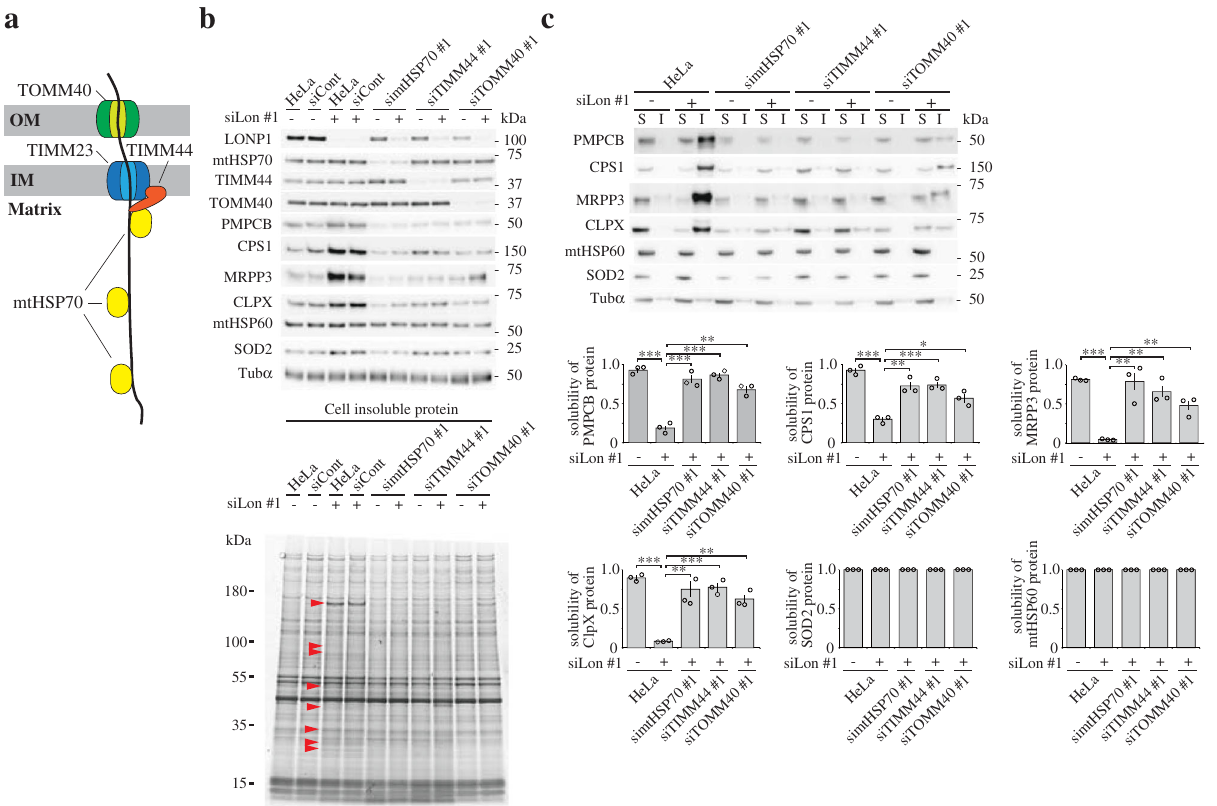
Fig. 3 Analysis of the relationship between the mitochondrial protein import machinery and protein aggregation caused by depletion of LONP1. a Model of mitochondrial protein import machinery. TOMM40 and TIMM23 are the central pore-forming subunits of the translocase complex in the mitochondrial outer membrane and inner membrane, respectively. TIMM44 is a peripheral inner membrane protein on the matrix side and mediates mtHSP70 attachment to TIMM23, and mtHSP70 binds incoming proteins to facilitate their translocation. b Analysis of insoluble proteins from HeLa cells treated with siRNAs. Cells were used for experiments 3 d after the second transfection. Upper panel , immunoblot analysis was carried out as described in the legend to Fig. 1a. Lower panel , comparison of insoluble proteins prepared from the cells was carried out as described in the legend to Fig. 1d. Red arrowheads indicate typical insoluble proteins speci fi c to LONP1 knockdown cells. The experiments were repeated three times and representative data are shown. c Upper panel , immunoblot analysis of soluble (S) and insoluble (I) proteins in the knockdown cells was carried out as described in the legend to Supplementary Fig. S2. Lower panel , the protein solubility was determined from the results of the immunoblot analysis using soluble and insoluble cell fractions. The protein solubility was quanti fi ed as the percentage of soluble proteins in the sum of soluble and insoluble proteins ( n = 3). Data were analyzed using the Student ’ s two-tailed t -test and are presented as means ± SD (* P < 0.05; ** P < 0.01; *** P < 0.001, Student ’ s t